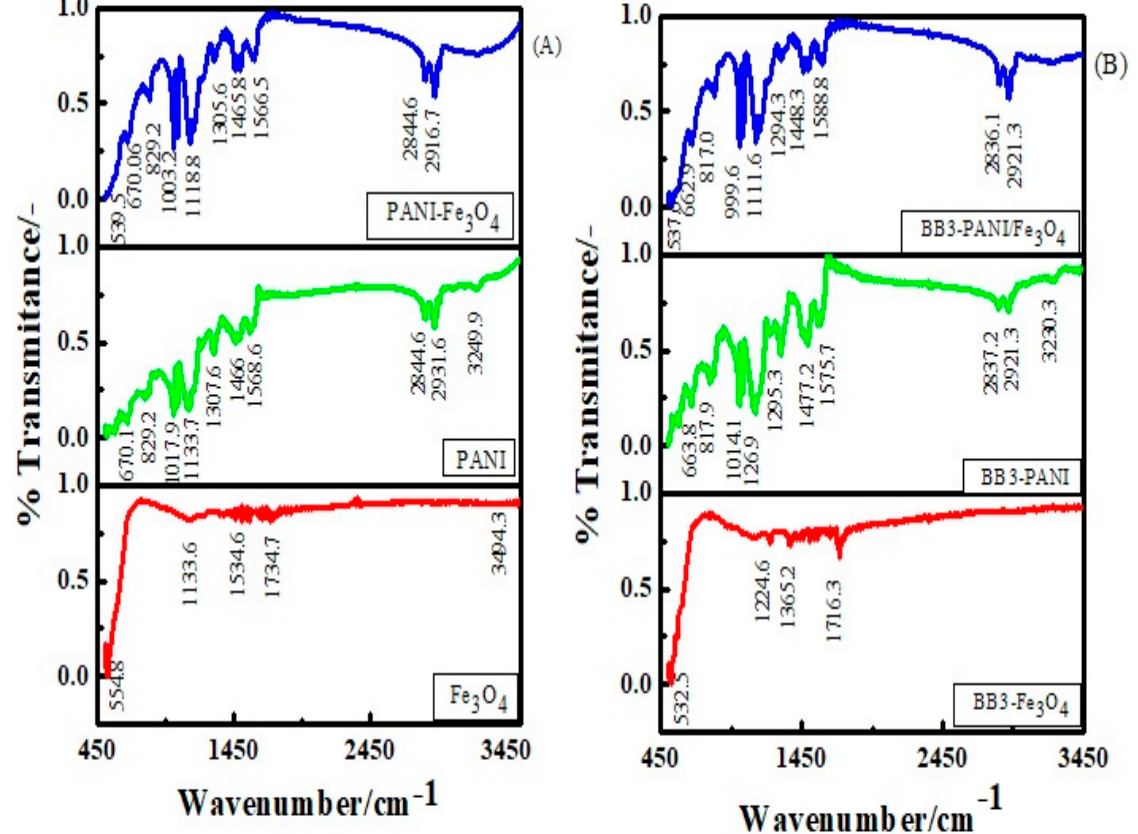
Figure 3. FTIR spectra of ( A ) Fe 3 O 4 , PANI, and PANI/Fe 3 O 4 before and ( B ) after adsorption of BB3.